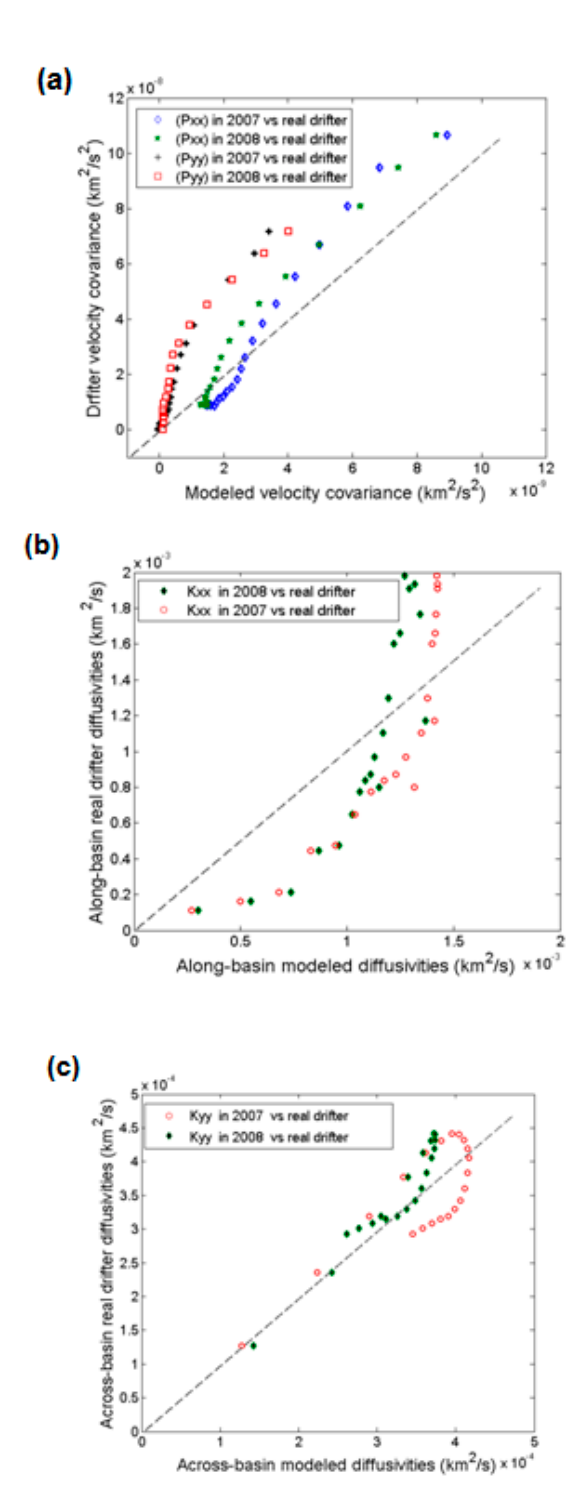
Figure 12. Comparison between the Lagrangian statistics in 2007 and 2008 and real drifter data ( a ) velocity covariance ( b , c ) diffusivity, Lagrangian integral length scale and Lagrangian integral time scale.